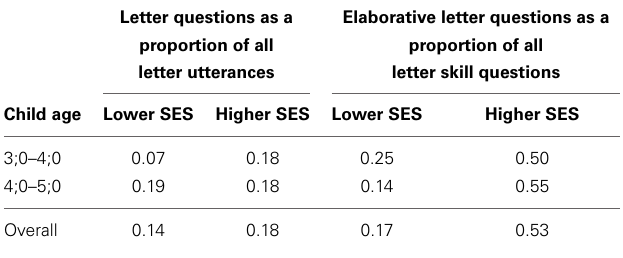
Table 1 | Proportion of letter statements in analysis 1 that included different types of questions, by SES and child